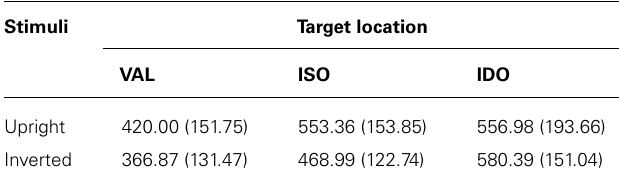
Table 2 | Infants’ mean latencies (SD) expressed in msec for the different target locations toward the upright and inverted faces. Stimuli